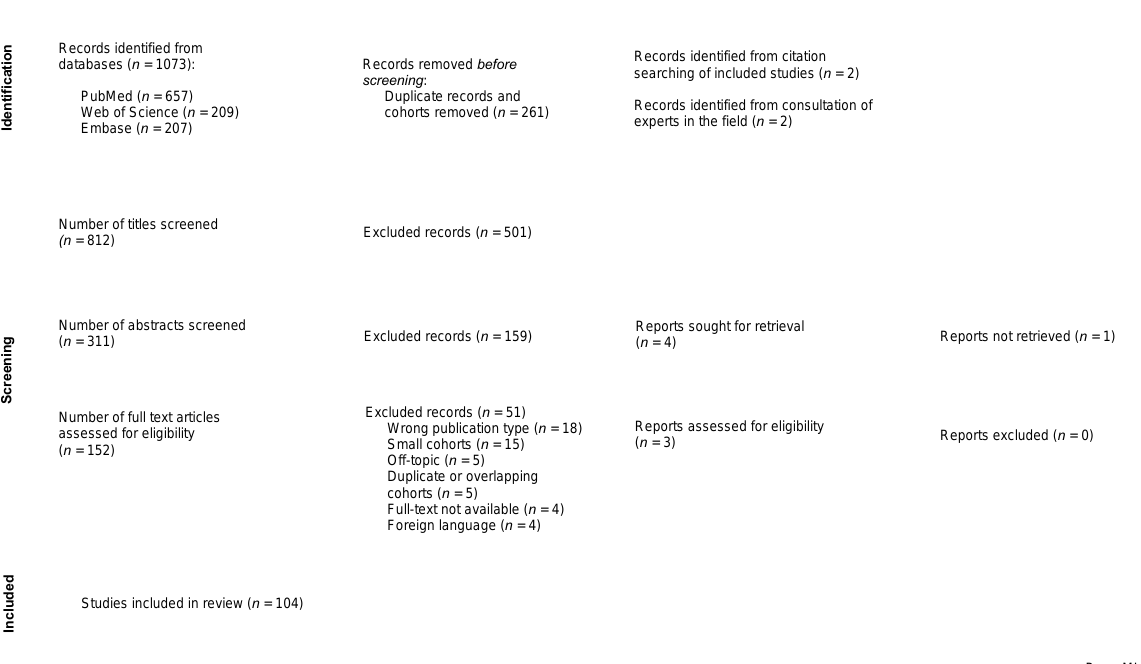
Figure 1. PRISMA flow chart illustrating the study selection process .